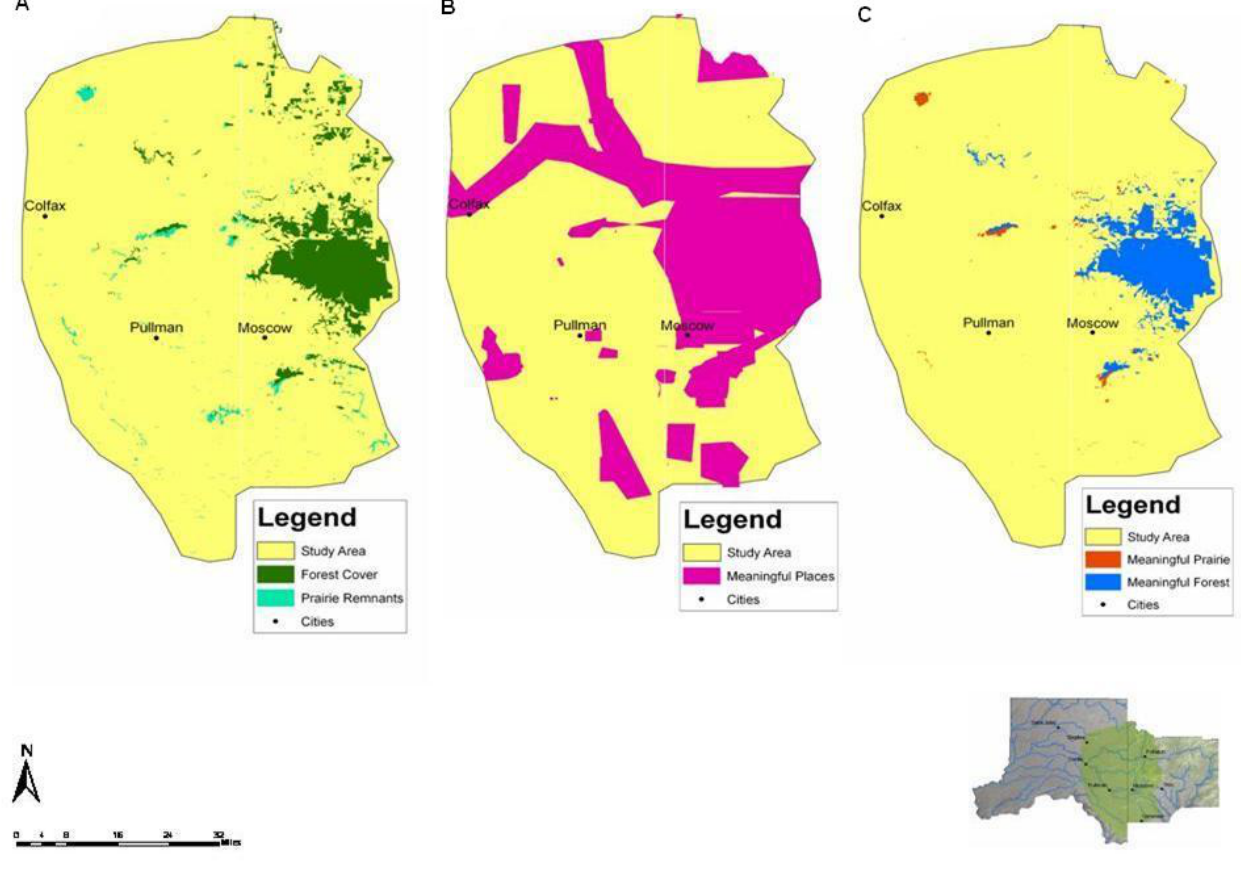
Fig. 2 . GIS layers of biologically important areas and socially meaningful places overlaid to show overlapping areas of Importance in study region. (A) Forest patches and prairie remnants within the study area. (B) Participant-mapped places used for interdisciplinary analysis. (C) Overlap of biologically and socially important places within the study